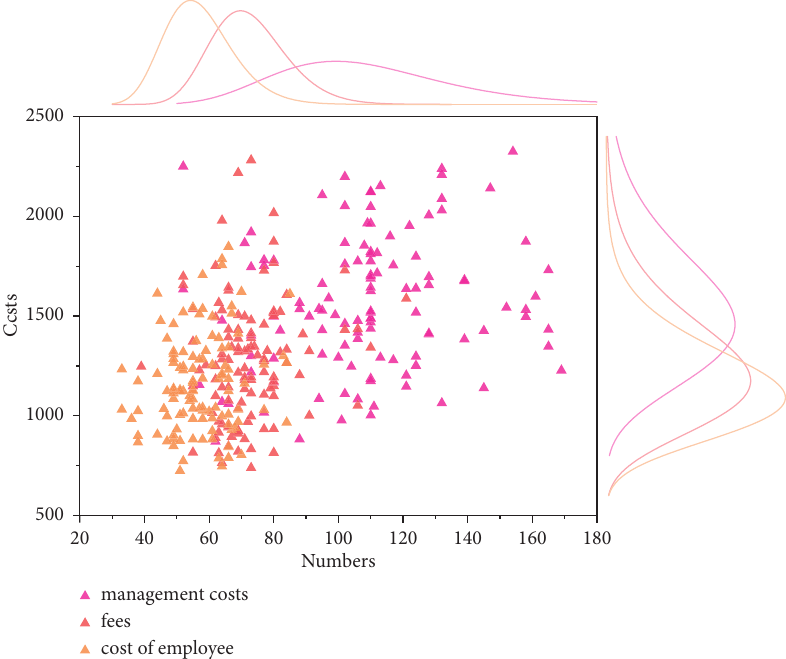
Figure 5: Indirect cost distribution of virtual network mapping collection based on the optimal subnetwork.